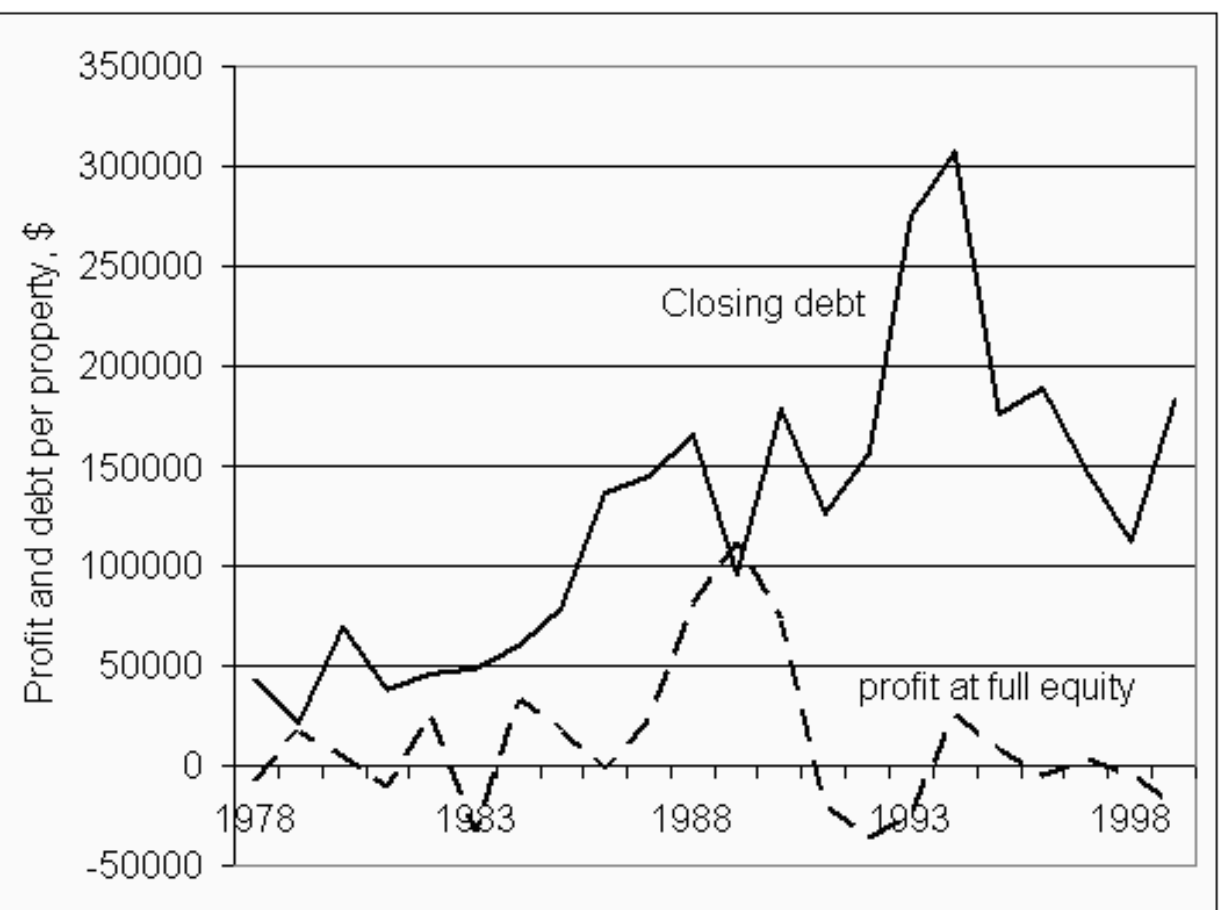
Fig. 8 . Pastoral profit and debt in New South Wales, Australia, according to the ASPIRE database of the Australian Bureau of Agricultural and Resource